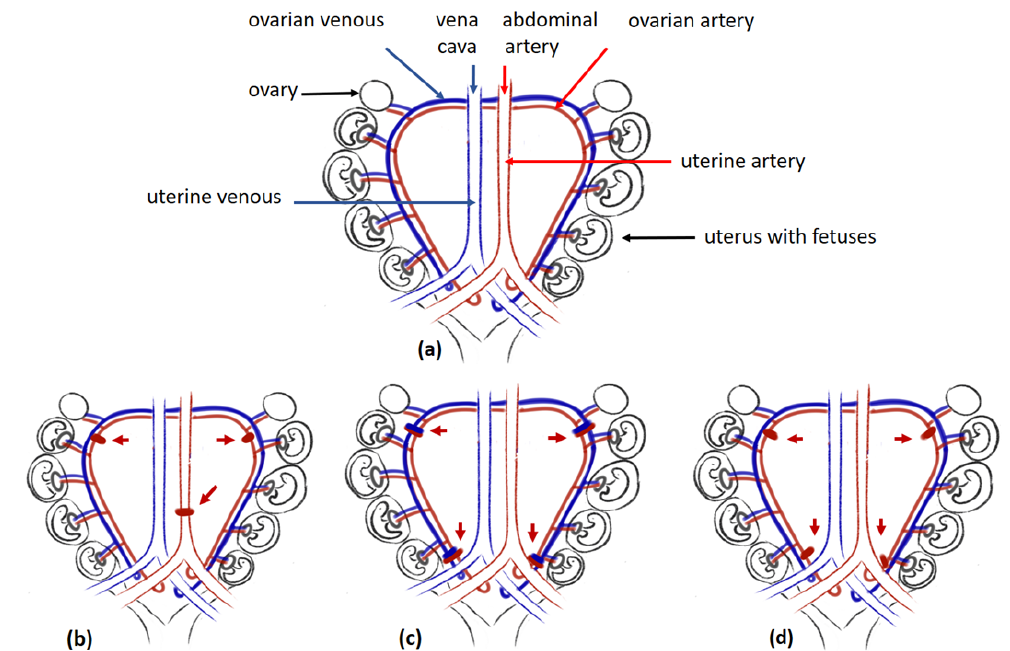
Figure 3. The RUPP models: ( a ) Uterus of rat, ( b ) conventional RUPP model, ( c ) new RUPP model, ( d ) selective RUPP model. Legend: red arrow pointing at silver clips placed around vessels; red clips are placed around the arteries; blue clips are placed around veins.